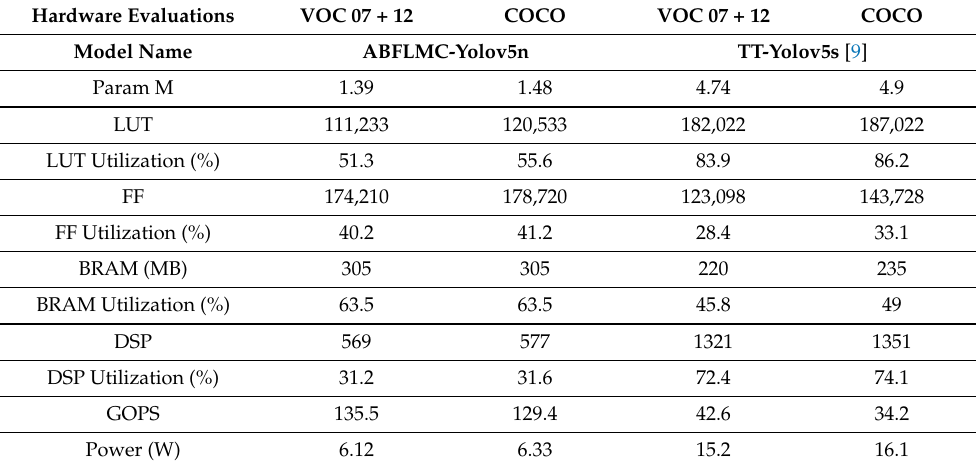
Table 3. Hardware evaluation in different